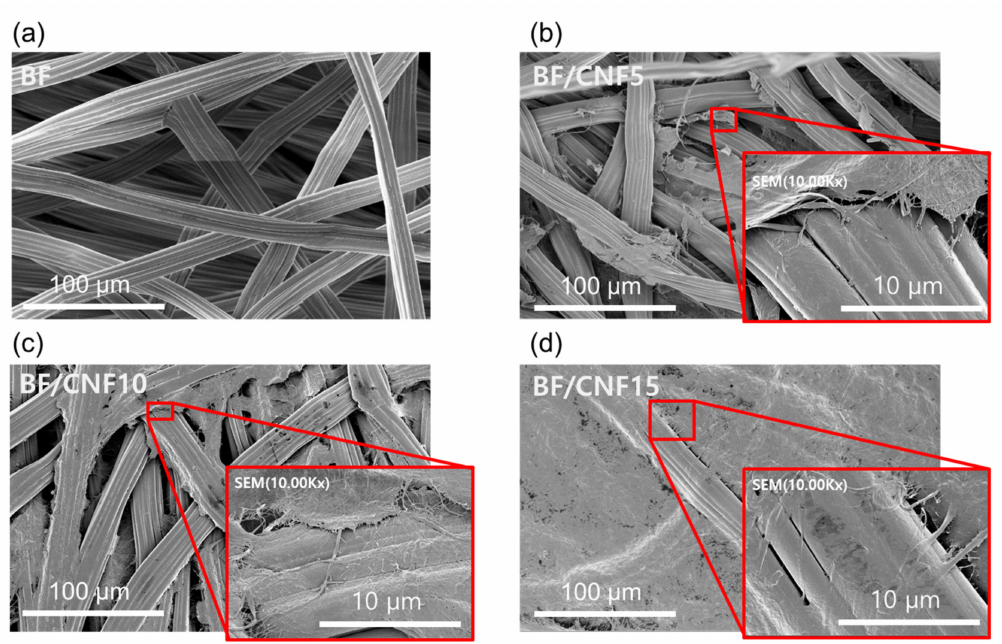
Figure 6. FE-SEM images of BF/CNF fibrous preforms with various amounts of CNFs. The insets represent high-magnitude images. ( a ) BF, ( b ) BF/CNF5, ( c ) BF/CNF10, and ( d )